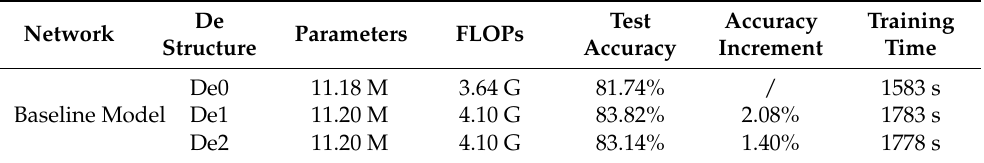
Table 4. Test results of the convolution kernel decomposition structure.